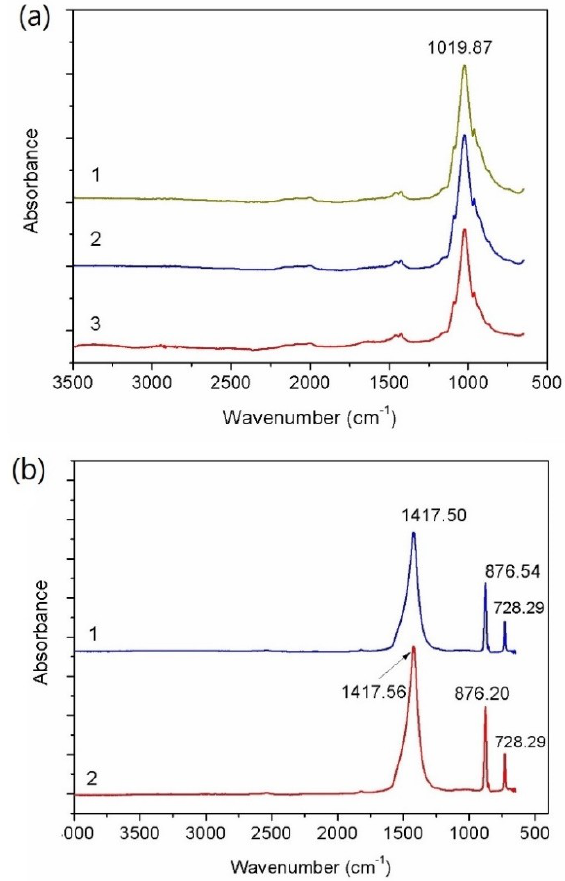
Figure 9. FTIR spectra of ( a ) FA samples (1—FA; 2—FA with 1 × 10 − 3 mol/L of H 2 SO 4 ; 3—FA with 1 × 10 − 3 mol/L of H 2 SO 4 and 2 × 10 − 4 mol/L of oleate); and ( b ) dolomite samples (1—dolomite and 2—dolomite with 1 × 10 − 3 mol/L of H 2 SO 4 ).